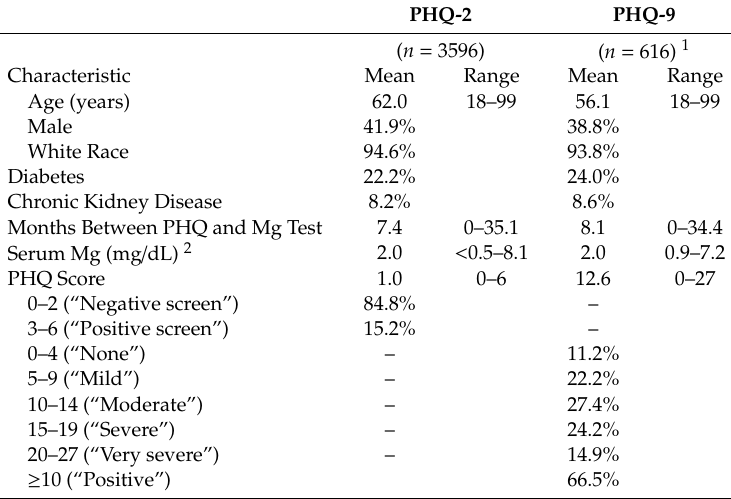
Table 1. Subject characteristics.